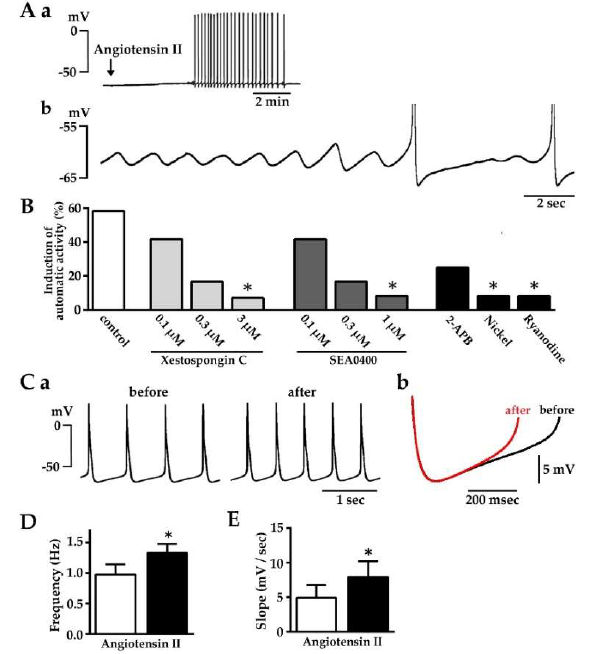
Figure 4. Effects of angiotensin II on automatic action potential firing and diastolic